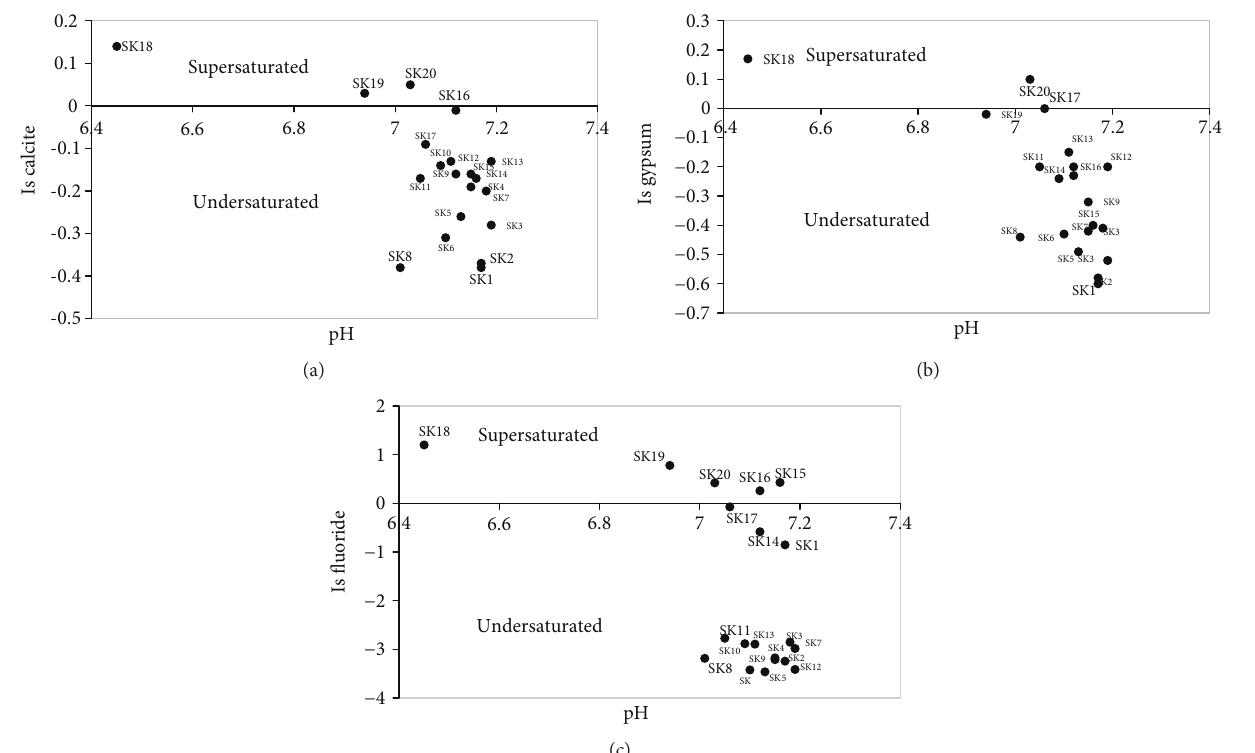
Figure 8: Saturation indexes of CaSO (SI) versus pH